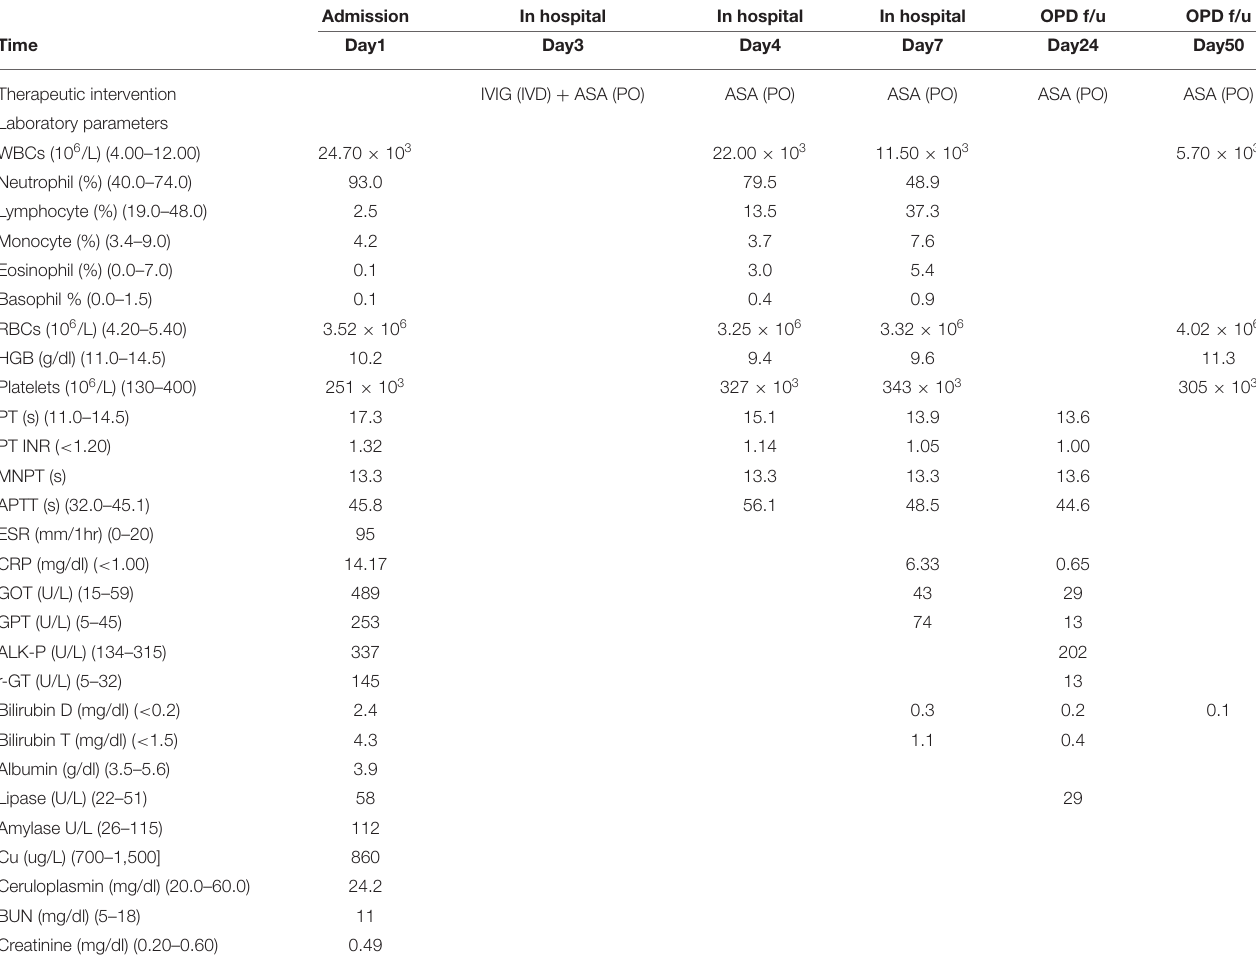
TABLE 2 | Laboratory data obtained during admission and